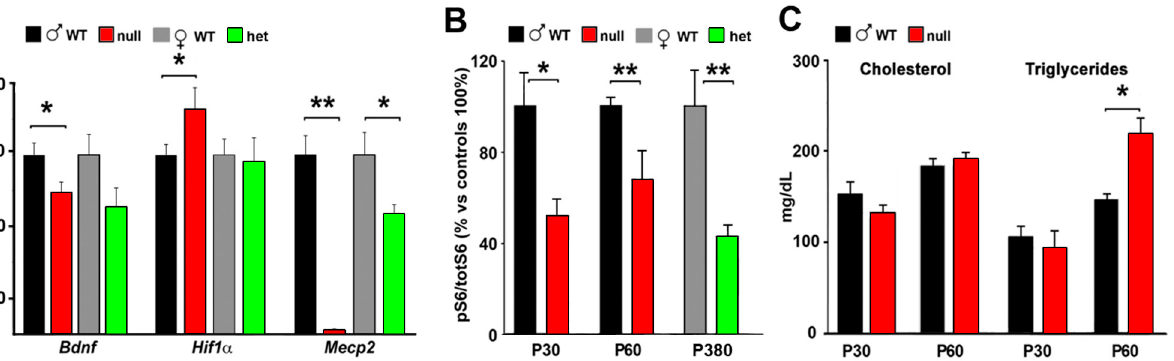
Fig 8. CD1 Mecp2 -null animals largely reproduce previously described molecular phenotypes. A : qPCRs comparing the expression of different genes (BDNF, Hif1 α , Mecp2 ) in CD1 wt or null males (P60), and wt or heterozygous females (P (cid:1) 240). Data are expressed as percentage of null or heterozygous samples versus wt male or female controls (100% ± SEM). (Student ’ s t-test; * = p < 0,05; ** = p < 0,01; n = 9 null, 10 wt males, 8 het and 9 wt females). B : Western blots representing the down-regulation of rpS6 phosphorylation (on serine 240 – 244) in CD1 null animals at P30 and P60 in males (n = 3 wt and 4 null at P30; n = 5 null and 7 wt at P60) and in Mecp2 +/- females at P (cid:1) 240 (n = 7 wt and 7 heterozygous). Statistical significance was evaluated through Student ’ s t-test; * = p < 0,05; ** = p < 0,01; C : Serum cholesterol and triglycerides levels in slightly and fully symptomatic animals. Statistical significance was evaluated through Student ’ s t-test; * = p < 0,05; n = 4 wt and 6 null at P30; n = 8 wt and 9 null at